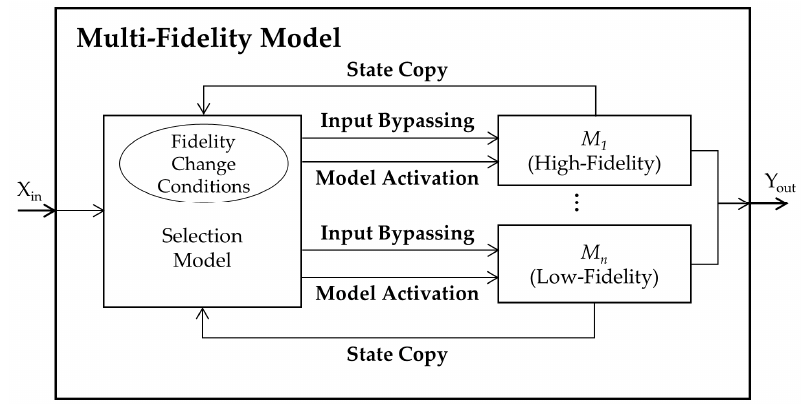
Figure 9. General structure of the multi-fidelity model.